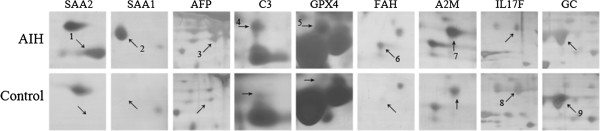
The spots with differential expression level between AIH and normal mouse sera. Spots labeled with the arrow were significantly changed. The spot 1–7 was up-regulated in AIH mouse serum, while the spot 8–9 was significantly decreased. The protein corresponding to the spot 1–9 was respectively identified as following, including SAA2, SAA1, AFP, C3, GPX4, FAH, A2M, IL17F and GC.